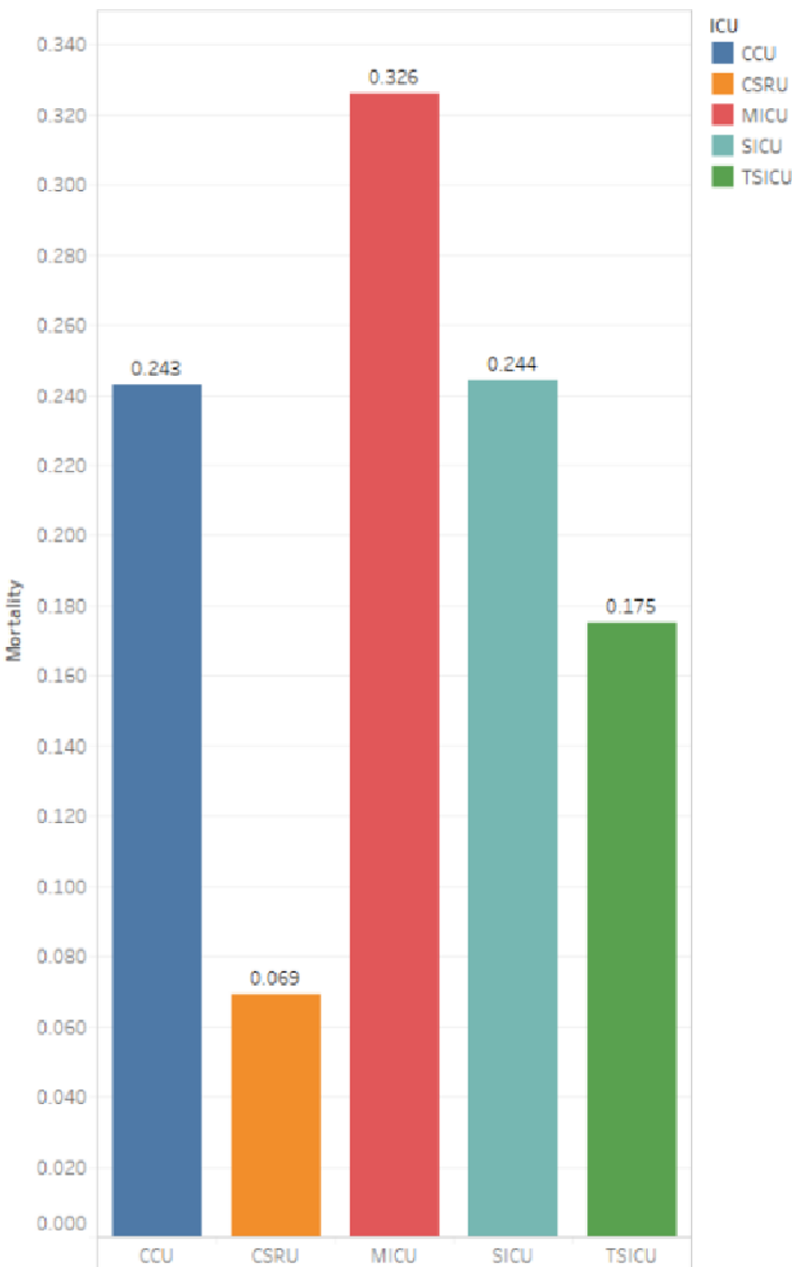
Fig 2. ICU mortality of all patients (in-hospital + 90-day after discharge). suffering from only one disease. No cross-replicated data for the diseases. The disease informa- tion of patients was counted according to the first diagnosis. The most common disease of patients admitted to hospital is Other forms of chronic ischemic heart disease, but the mortal- ity rate of this category is the lowest in the ten diseases. The 90-day mortality rate and in-hospi- tal mortality of Septicemia disease are the highest among the ten diseases. Heart failure has the highest median age among the ten diseases it is 77 years (Q1-Q3:66–85).